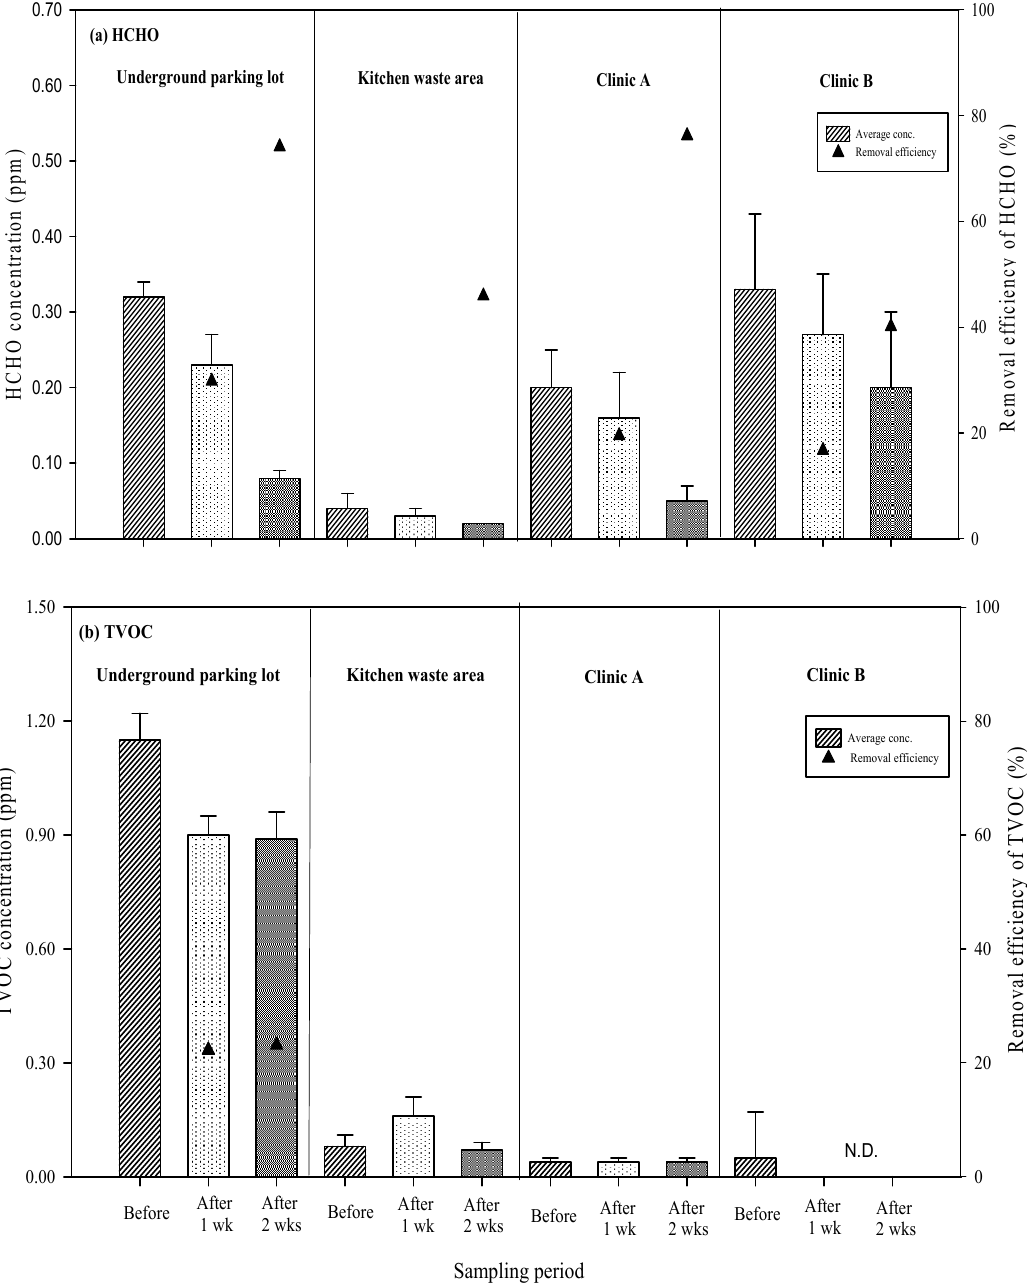
Figure 4. E ffi ciency of chemical air pollutants: ( a ) HCHO and ( b ) TVOC removal by long-term UVGI exposure.